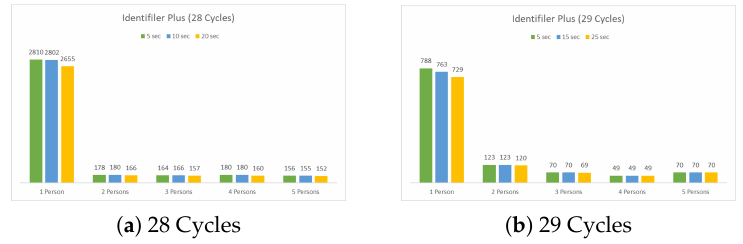
Figure 13. The number of profiles for Identifiler Plus multiplex.